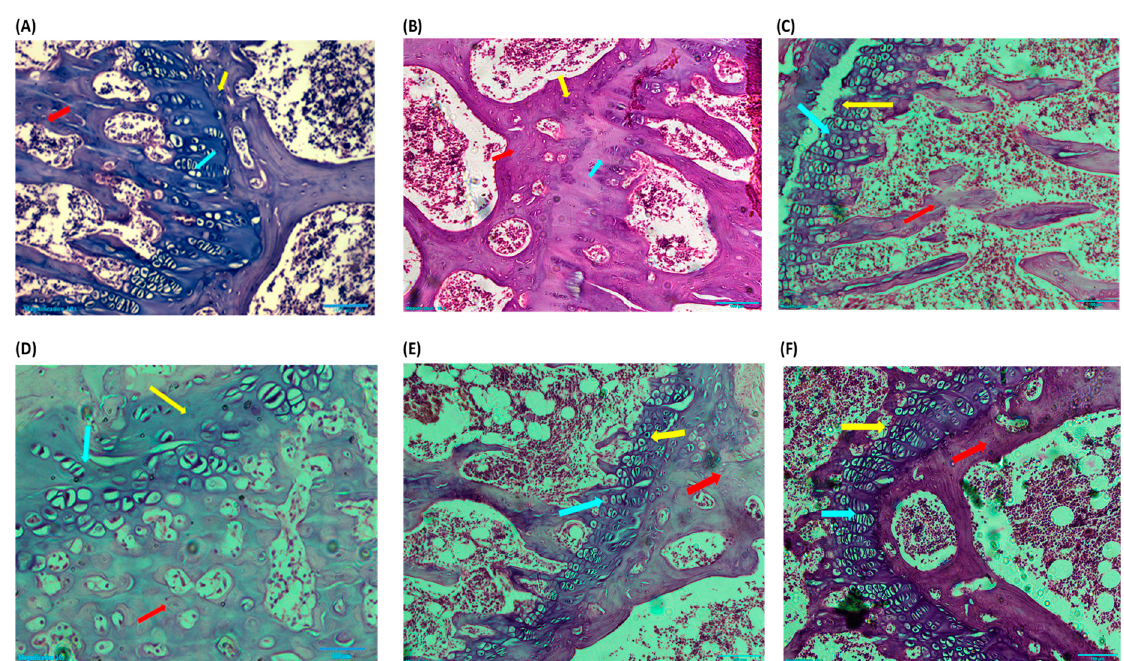
Figure 3. Impact of chrysin on histopathology of bone. ( A ) Group I (normal group); ( B ) Group II (disease control); ( C ) Group III (chrysin); ( D ) Group IV (chrysin + CaCO 3 ); ( E ) Group V (chrysin + vitamin D 3 ); and ( F ) Group VI (chrysin + vitamin D 3 + CaCO 3 ) showing alterations in normally growing cells (blue arrow) at the epiphyseal plate (yellow arrow) along with osteocytes (red arrow) in the bone matrix.